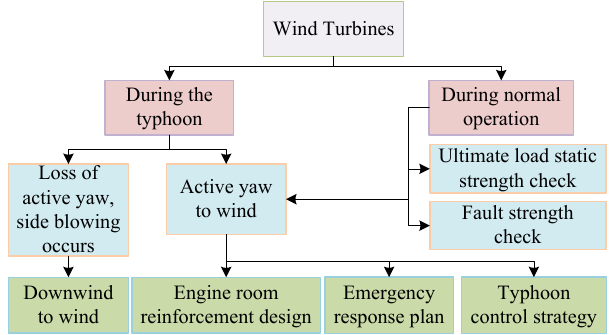
Figure 21. Anti-typhoon strategy for offshore wind